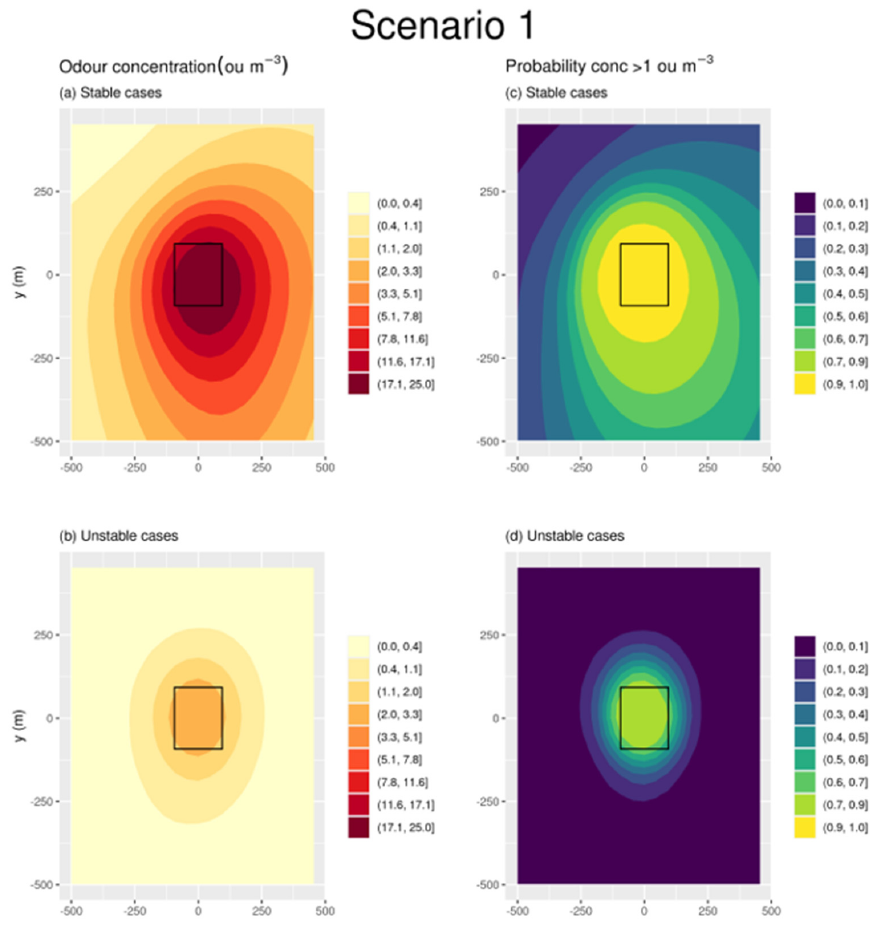
Figure 8. Odour concentrations (left panel) and exceedance probability of the 1 ou m − 3 threshold (right panel) at a 1.7 m height as simulated by SCICHEM for the period 1 October 2020–31 October 2020, for scenario 1. Modeled concentrations and probabilities are represented for the stable ( a , c ), and unstable cases ( b , d ). The square in the center represents the fertilized field (emission source), and the x and y coordinates are expressed as the distances in meters from the center of the source.